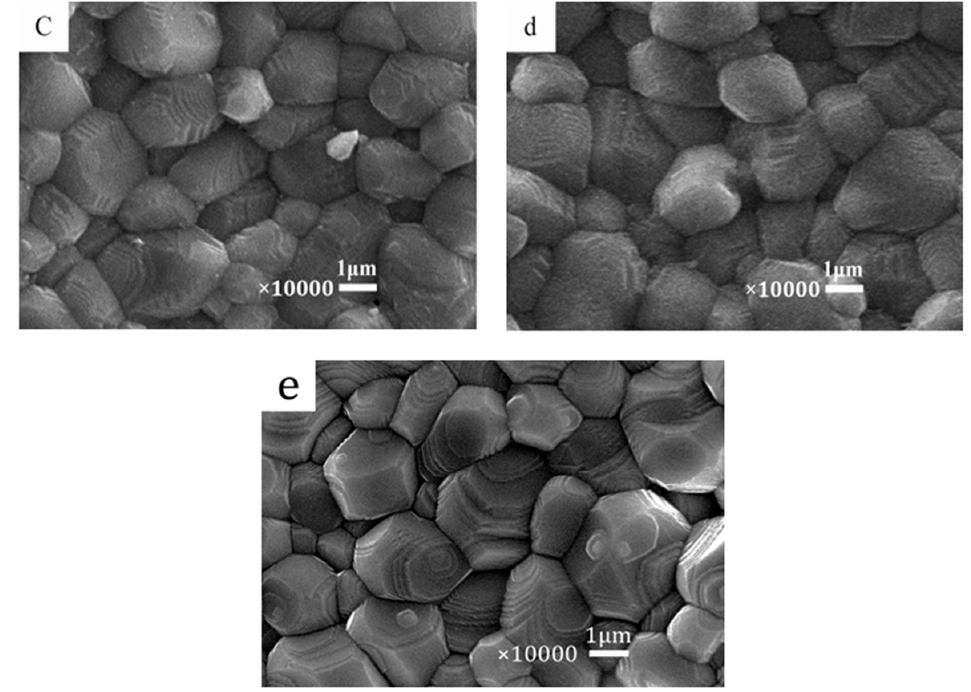
Figure 2. SEM micrographs of 0.95CST–0.05BNT samples sintering at 1300 °C by microwave sintering (MWS), with different holding times: ( a ) 20 min, ( b ) 30 min, ( c ) 40 min, ( d ) 50 min; ( e ) 1275 °C hold for three hours by conventional sintering (CS).